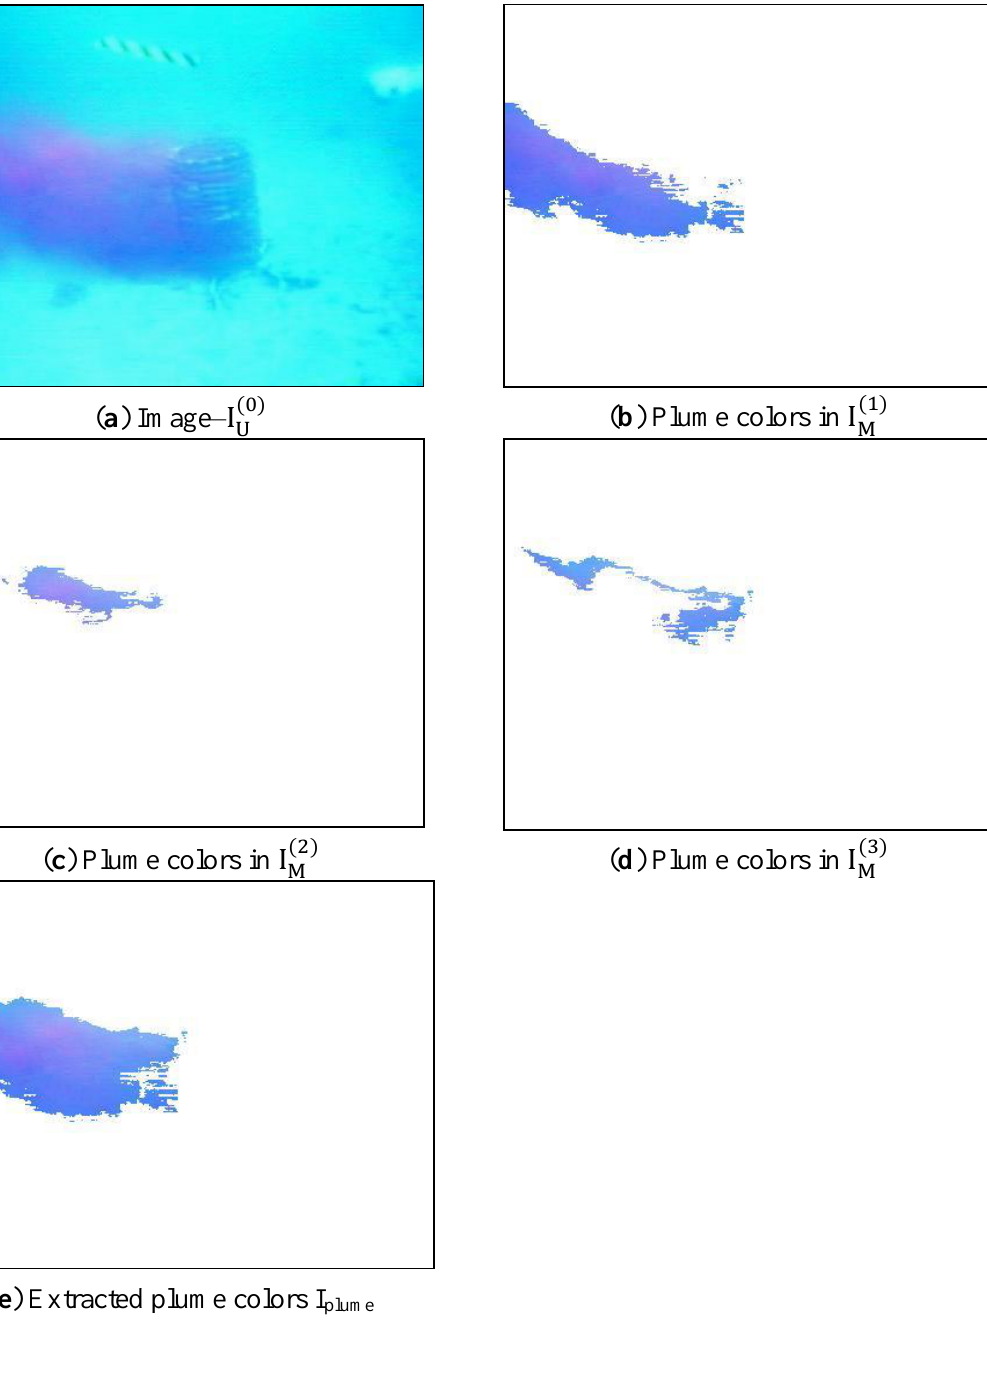
Figure 11. Extraction of the rhodamine dye plume and its